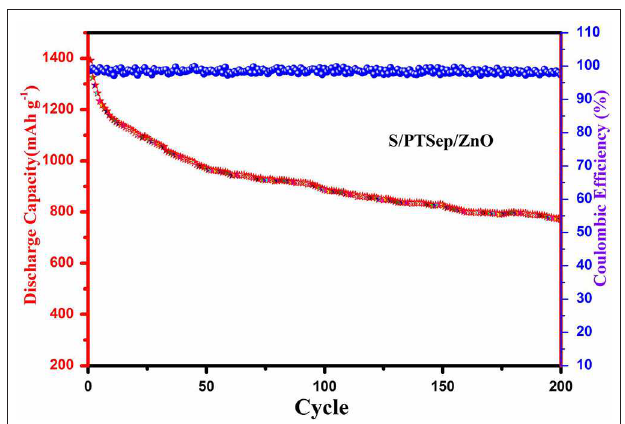
FIGURE 11 | Cyclic performance and the Coulombic efficiency of S/PTSp/ZnO Composites under discharge rate of 0.1C.